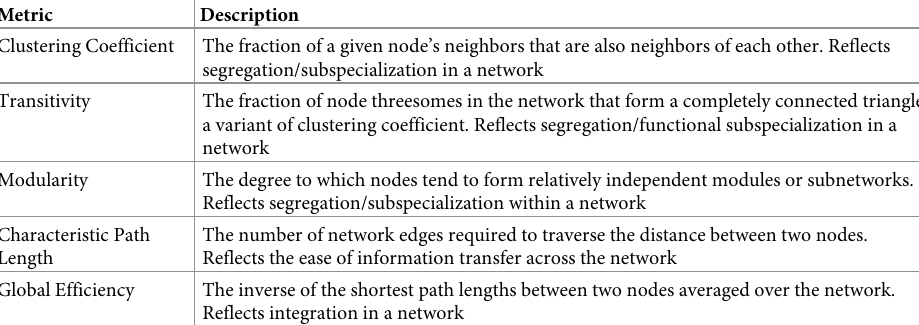
Table 1. Graph theoretical metrics of global network